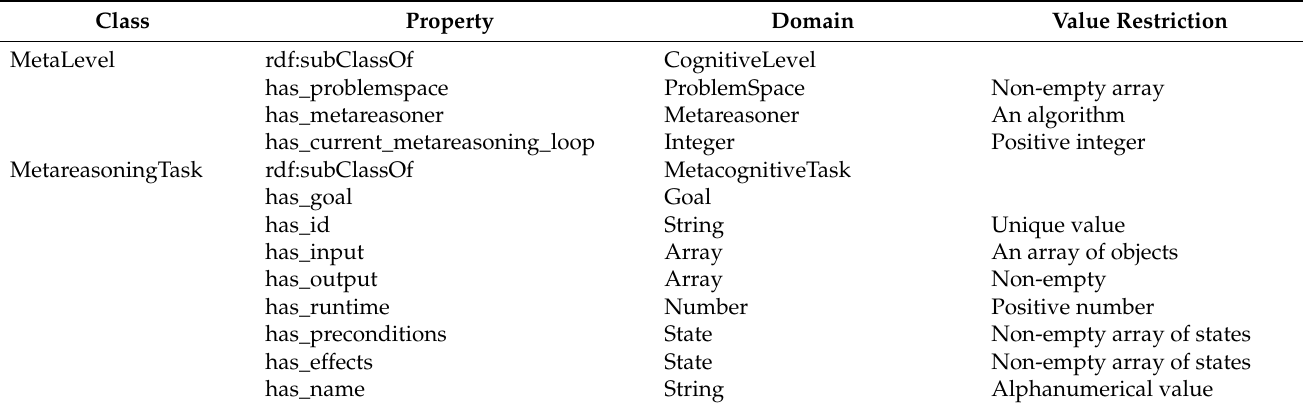
Figure 4. Class hierarchy extracted from a previous ontology in (Schmill et al. 2007). Figure elabo- rated by the authors. Finally, other ontological hierarchies arose from the process of concept abstraction. For example, reasoning tasks and metareasoning tasks abstract the task class. In this ontology, the information about the metareasoning process is modeled accord- ing to the standard vocabulary that facilitates a better semantic interpretation that can resolve ambiguities in the terms used in the different data sets, metareasoning applica- tions, or when a little additional knowledge can lead to the discovery of new relationships between terms. In this sense, this ontology is designed to semantically represent a rich and complex knowledge about the domain of metareasoning in intelligent systems. The semantic relationships in the ontology are given through hierarchical relation- ships of type Is-Un. When a relationship of this type is established between two classes, one is a superclass, and the other is a subclass. The subclass shares the structure and be- havior of the superclass. In the same way, the “HAS” relationships have been imple- mented, which are structural and describe a set of links, which describe composition con- nections between the terms. The ontology has mechanisms to verify the consistency of this knowledge and make explicit the implicit knowledge that can be generated in the monitoring and control pro- cesses of reasoning in intelligent systems. 3.4. Implementation: The Integrated Metareasoning Ontology (IM-Onto) This section presents the technical details of the Integrated Metareasoning Ontology (IM-Onto). To make an ontology machine-readable, it is important to represent it in a for- mal computational language (Noy and Mcguinness 2001). Hence, IM-Onto was imple- mented using OWL/RDF (Allemang et al. 2005) in the Protégé environment (Horridge et al. 2019). The advantage of using OWL/RDF is that it allows for richer semantic expressions of concepts, their attributes, and the relationships between them. At the same time, the use of the OWL/RDF model supports improved interoperability or connection of information silos with the added merit of being able to generate implicit semantic inferences based on defined relationships (Horridge et al. 2019). In the context of this study, the use of this model for linking information enables a machine-readable representation (through uni- form resource identifiers) that also solves a vocabulary problem in this domain. In the context of this study, the use of this model for metareasoning enables a machine-readable